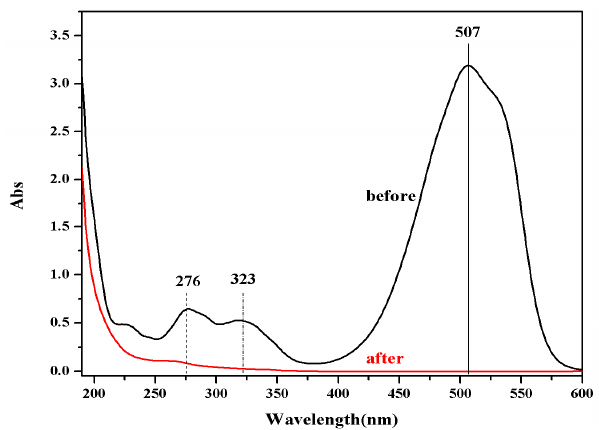
Figure 10. UV-vis spectra of MO before and after degradation.